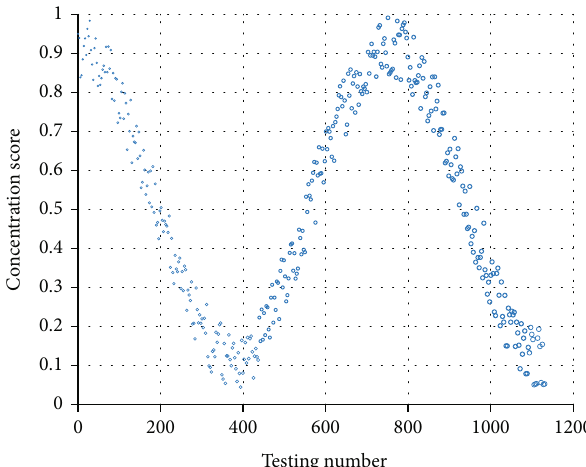
Figure 4: Line chart of student concentration